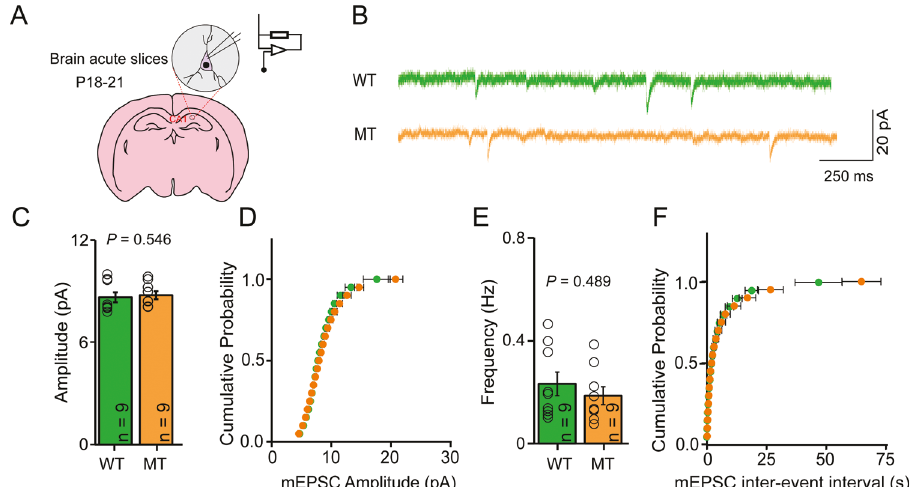
Fig. 6 Both the amplitude and the frequency of mEPSCs showed no signi fi cant difference between SLC39A8-p.393T knock-in mice and wild-types. A Overview of electrophysiological recording on acute slices from hippocampus. B Representative traces of mEPSC in wild-types (green) and SLC39A8-p.393T knock-in mice (orange) CA1 neurons. (Scale bars (20 pA and 250 ms) for single representative mEPSC traces). C The mEPSC amplitude did not change signi fi cantly in SLC39A8-p.393T knock-in neurons compared with wild-types ( P = 0.546) (WT: 8.66 ± 0.29 pA, MT: 8.78 ± 0.24 pA). D Cumulative distribution functions of mEPSC amplitude showed no irregularities between SLC39A8- p.393T knock-in mice (green) and wild-types (black). E There was no signi fi cant change in mEPSCs frequency between SLC39A8-p.393T knock- in neurons and wild-types ( P = 0.489) (WT: 0.23 ± 0.05 Hz, MT: 0.19 ± 0.03 Hz). F Cumulative distribution functions of mEPSC frequency showed no irregularities between SLC39A8-p.393T knock-in mice (green) and wild-types (black). Mann – Whitney U test with Bonferonni correction was used for statistical test, data represent mean ± SD, n = 9 for C – F